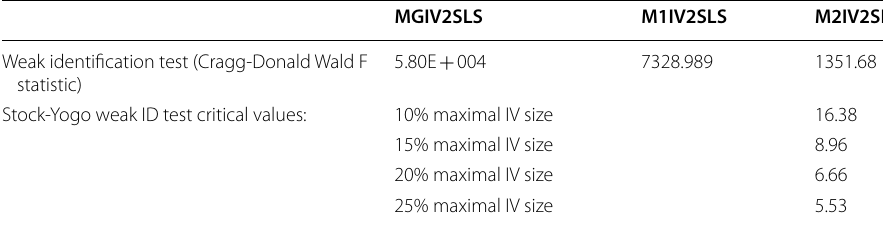
Table 7 Weak instrumental variables